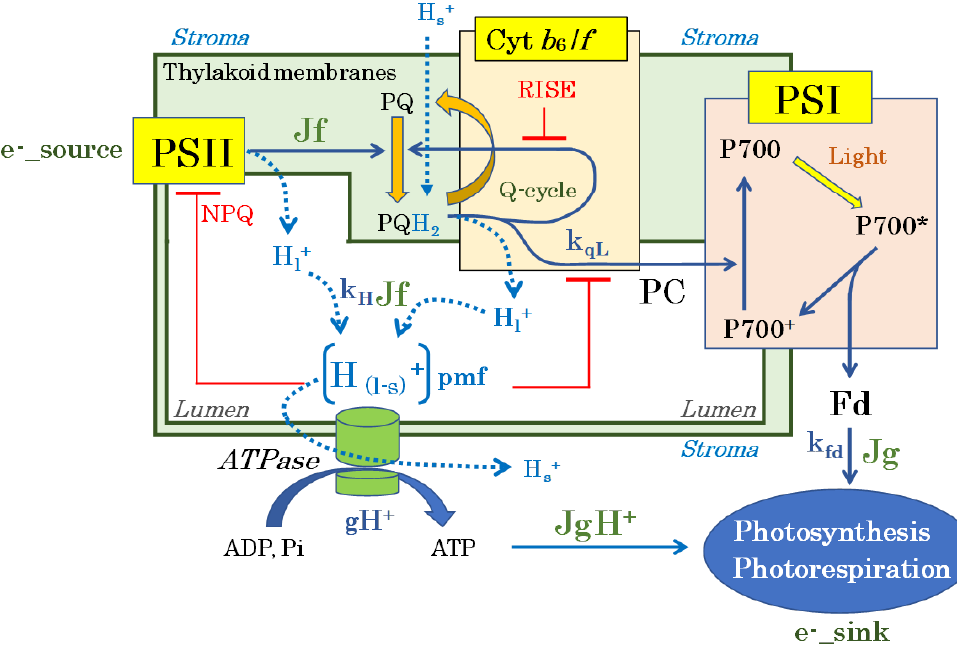
Figure 4. Tight coupling between the light and the dark reactions in photosynthesis of C3 angiosperms. Blue arrows: electron flow; blue dotted arrows: H + flow; Hs + : stroma H + ; H l + : lumen H + ; [H( l − s ) + ]: difference in H + concentration ( ∆ pH) between the stroma and the lumen, i.e., the proton motive force (pmf). Photosystem II (PSII): electron source. P700 functions in the photo-oxidation